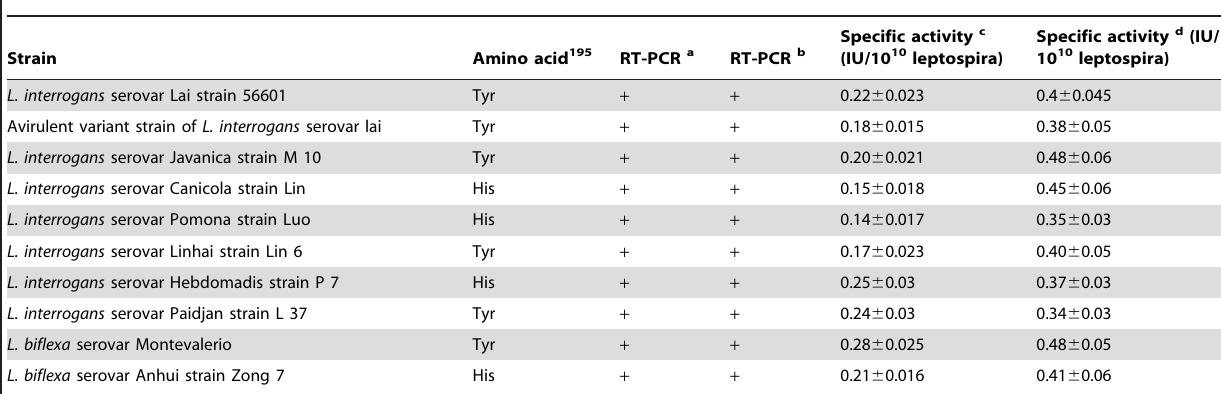
Table 2. The amino acid 195 , RT-PCR and specific activity of PAF-AH in ten leptospires cultured in EMJH and Korthof media.